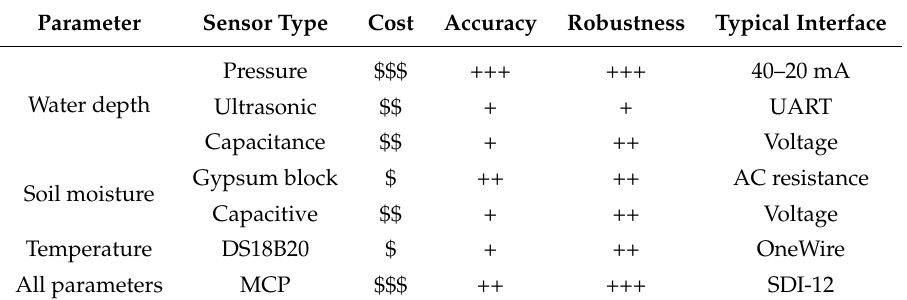
Table 2. Comparison of using an MCP versus other sensor combinations to measure water depth, soil moisture and